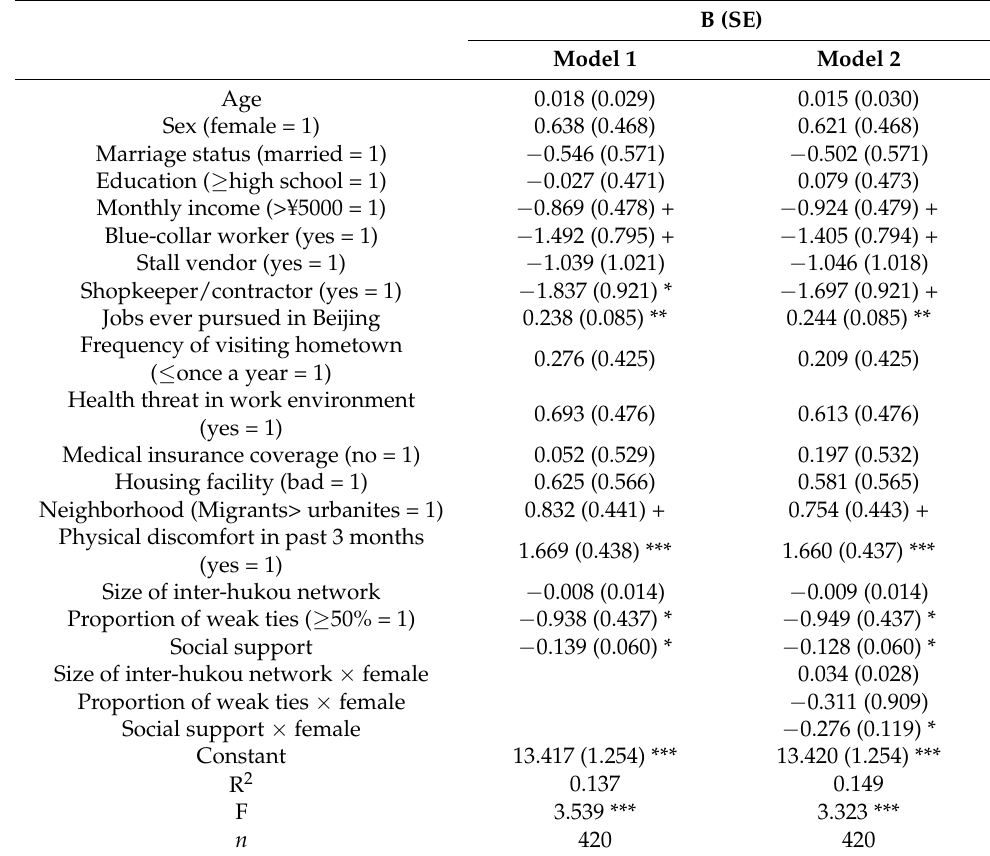
Table 2. Multivariate linear regression analysis of the association of the inter-hukou network with mental